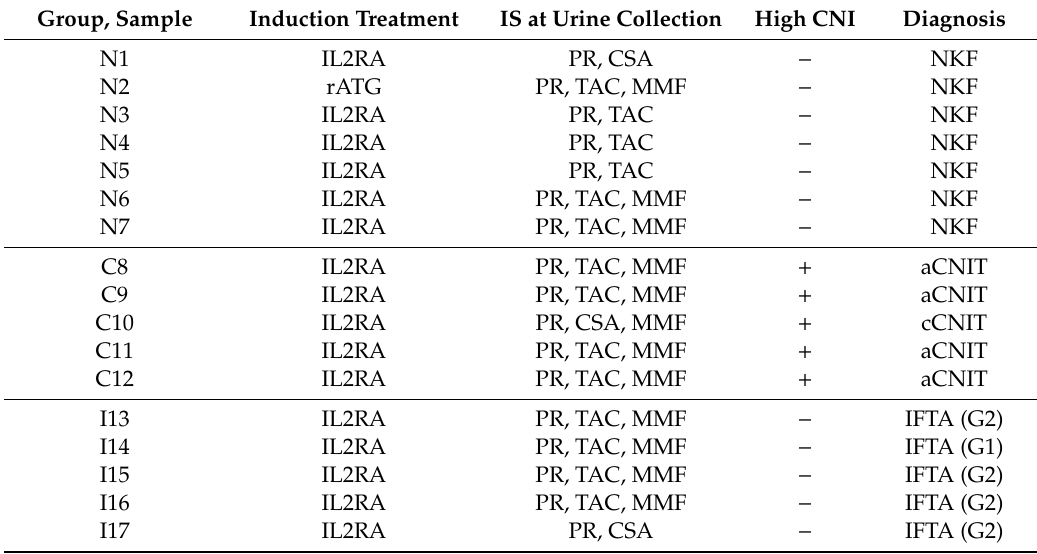
Table 2. Immunosuppression regime at urine